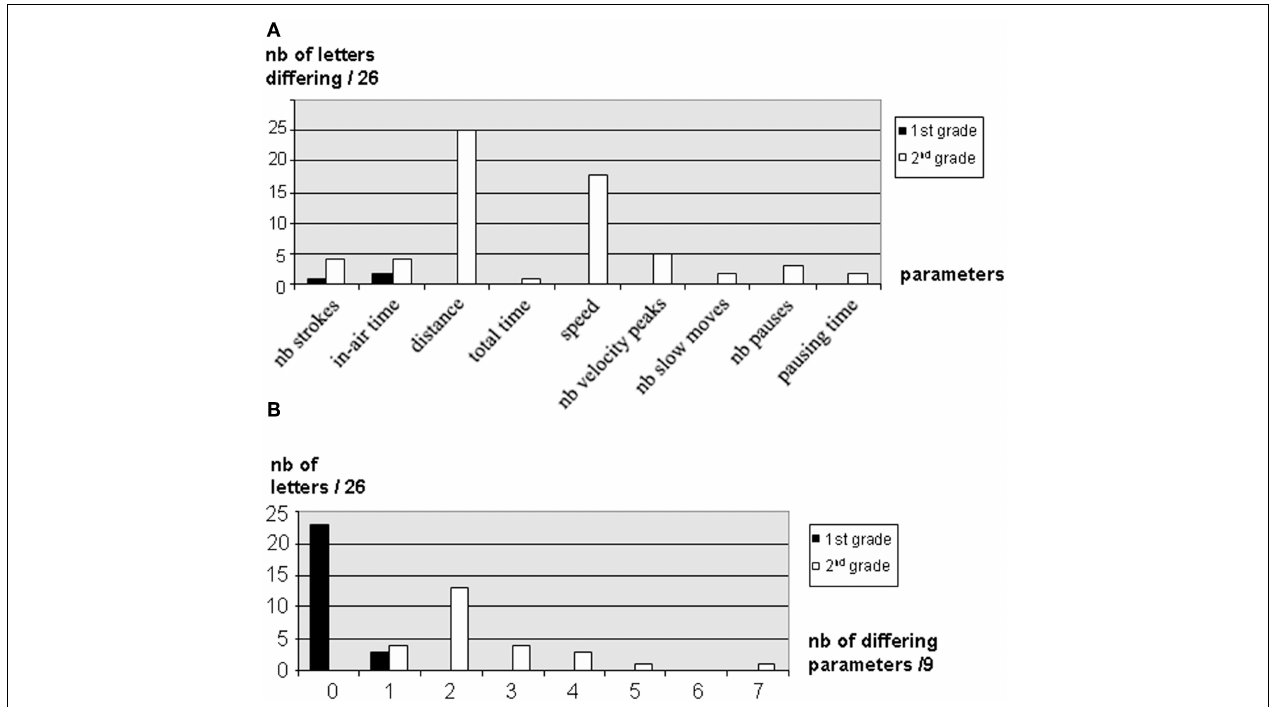
FIGURE 4 | Comparison between the DCD child’s results for isolated letters and those of the 2 control groups. Results of the DCD child were compared to those of first-graders (black bars) and second-graders (white bars). (A) For each parameter, the bars indicate the number of letters for which this parameter is significantly different